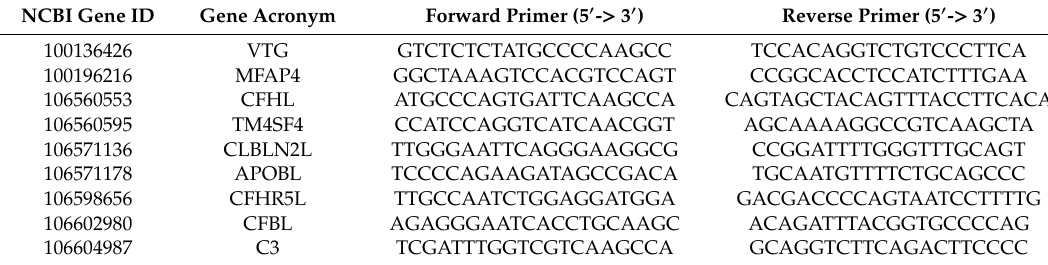
Table 3. List of the primers used in this